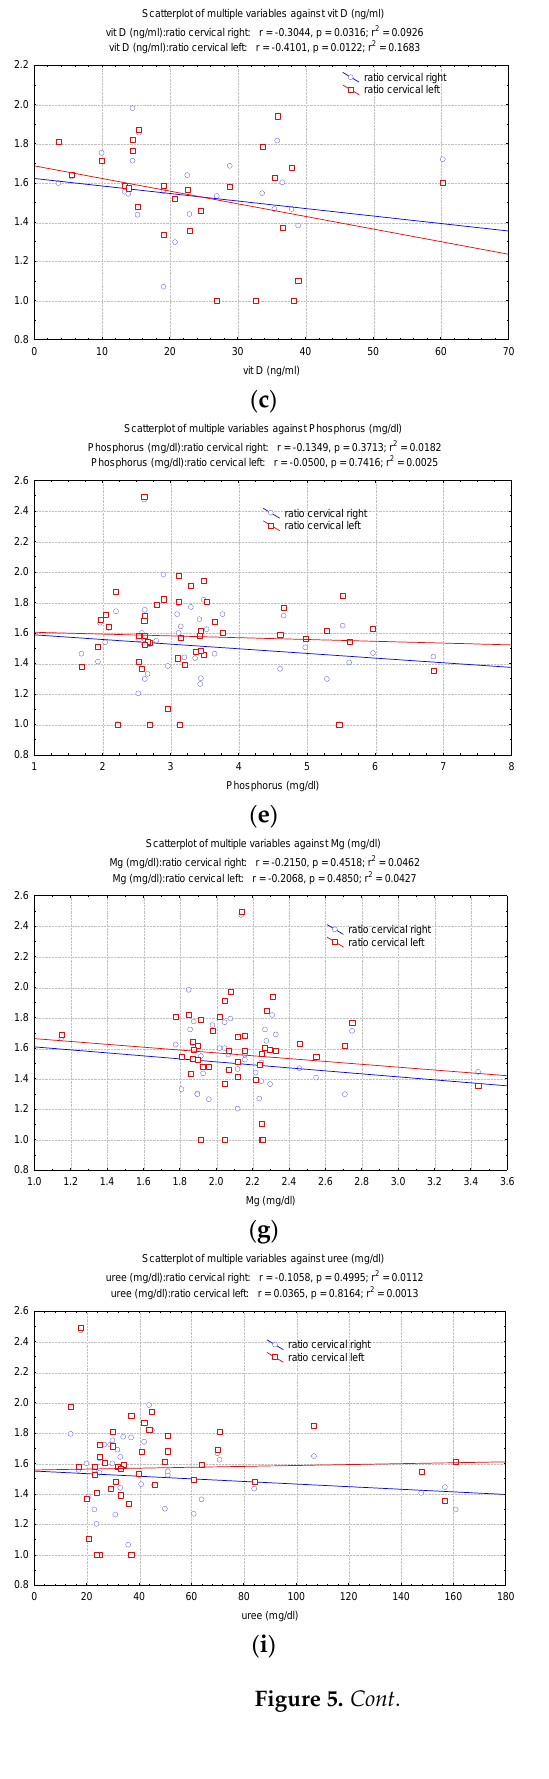
Scatterplot of multiple variables against Phosphorus (mg/dl) Phosphorus (mg/dl):ratio supraclavicular right: r = -0.1457, p = 0.3339; r 2 = 0.0212 Phosphorus (mg/dl):ratio supraclavicular left: r = -0.1489, p = 0.3235; r 2 = 0.0222